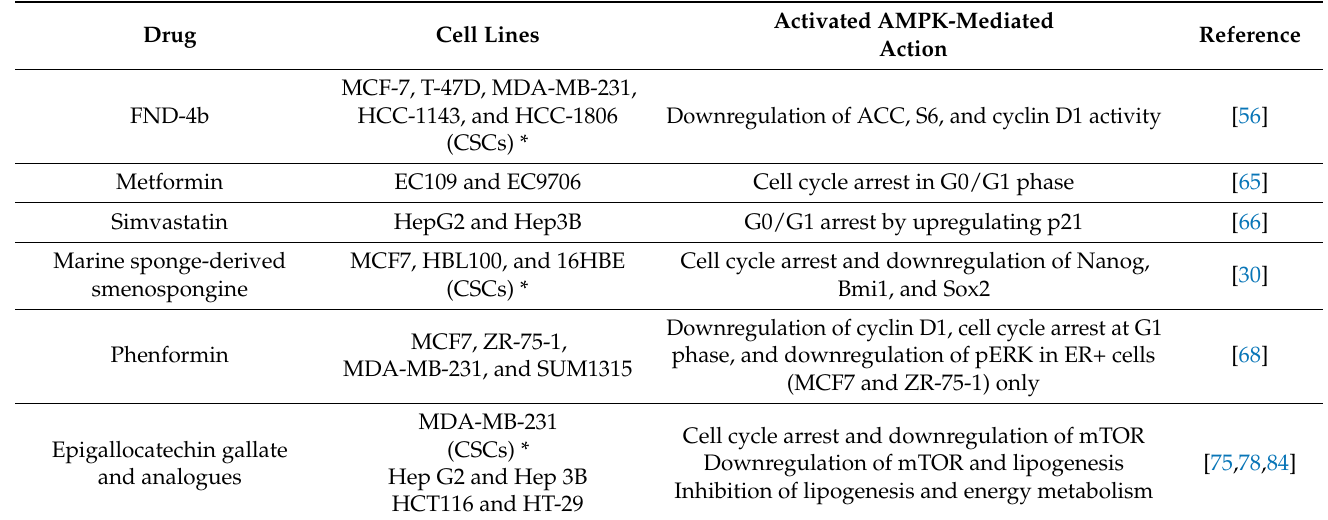
Figure 5. Cellular pathways associated with AMPK activation in cancer and cancer stem cells. The figure depicts various important molecular pathways mediated by AMPK activation that play pivotal roles against cancer and cancer stem cells. Table 1. Some recently reported compounds with anticancer action following AMPK